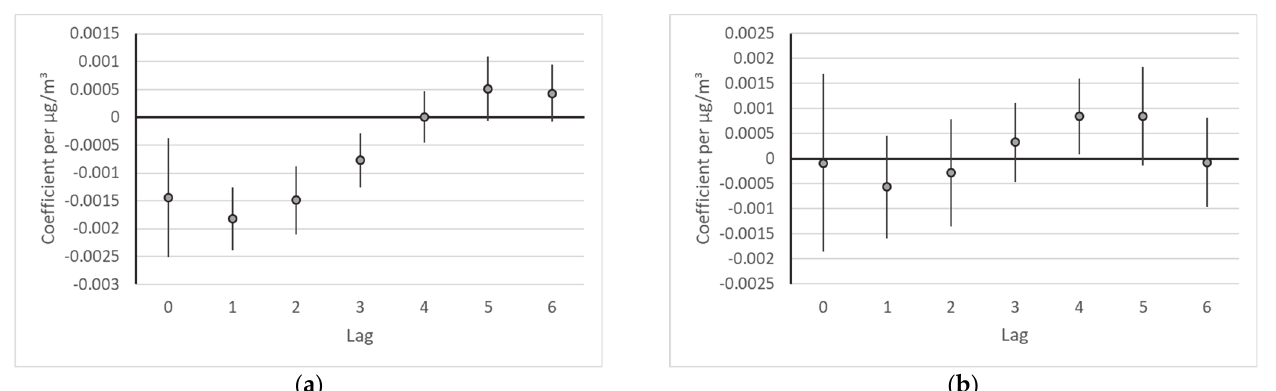
Figure 1. Effect estimates for each lag day from the distributed lag model. Coefficients per μ g/m³. ( a ) Respiratory visits; ( b ) cardiovascular visits.